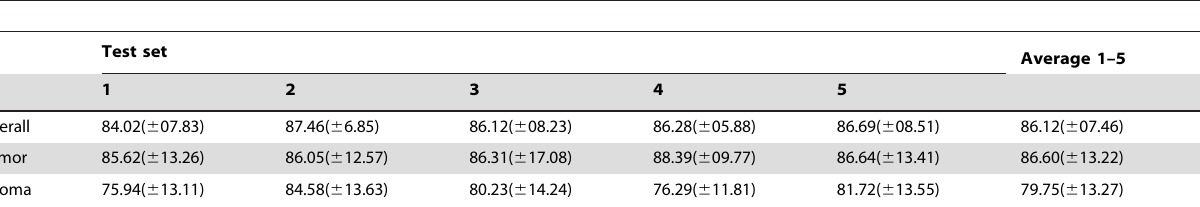
Table 5. The accuracies of the slides of the test set with the additional single node classification.